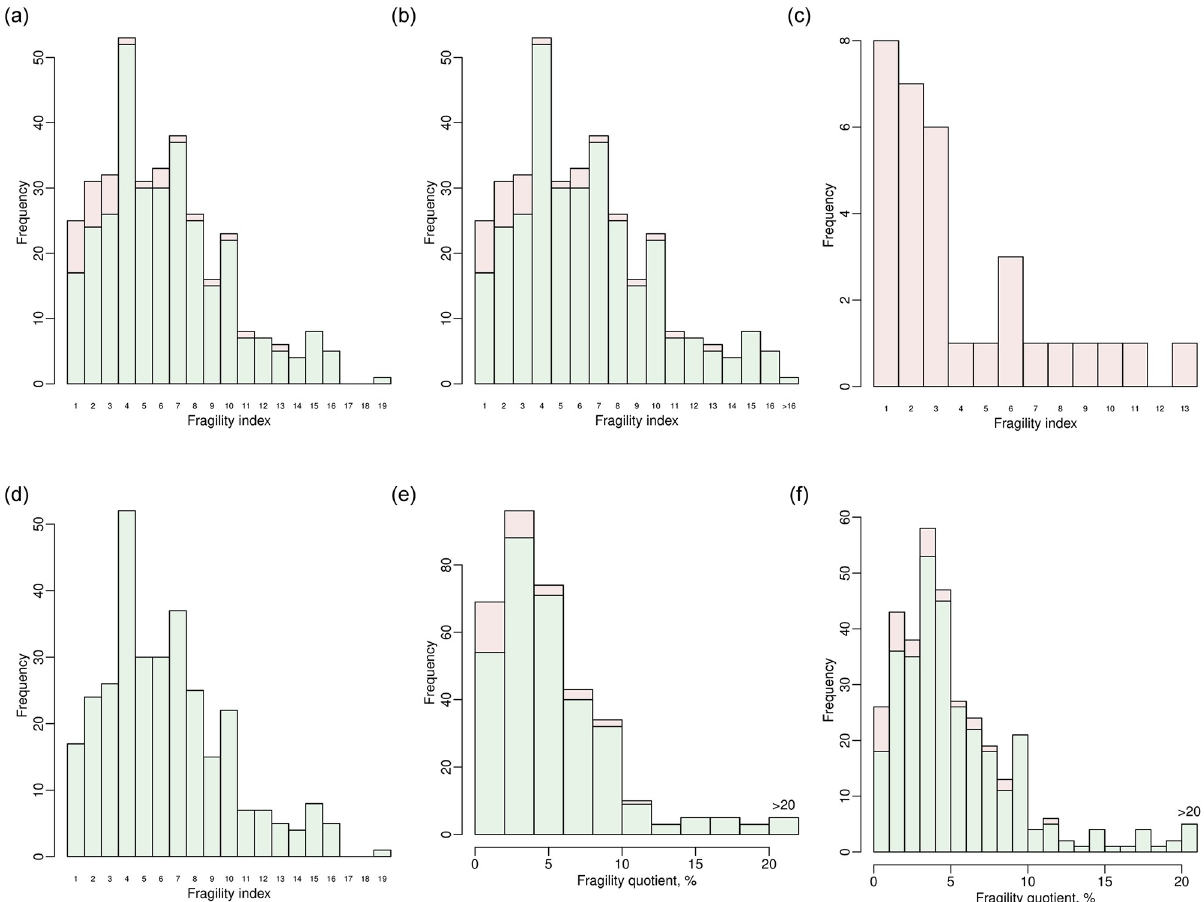
Fig 10. Distributions of fragility measures of the clinical trials in the dataset dat.ad . (a) Bar plot of fragility indexes of all trials. (b) Bar plot fragility indexes of all trials truncated at 16. (c) Bar plot of fragility indexes of trials whose significance altered to non-significance. (d) Bar plot of fragility indexes of trials whose non-significance altered to significance. (e) Histogram of fragility quotients of all trials. (f) Histogram of fragility quotients of all trials with more breaks.